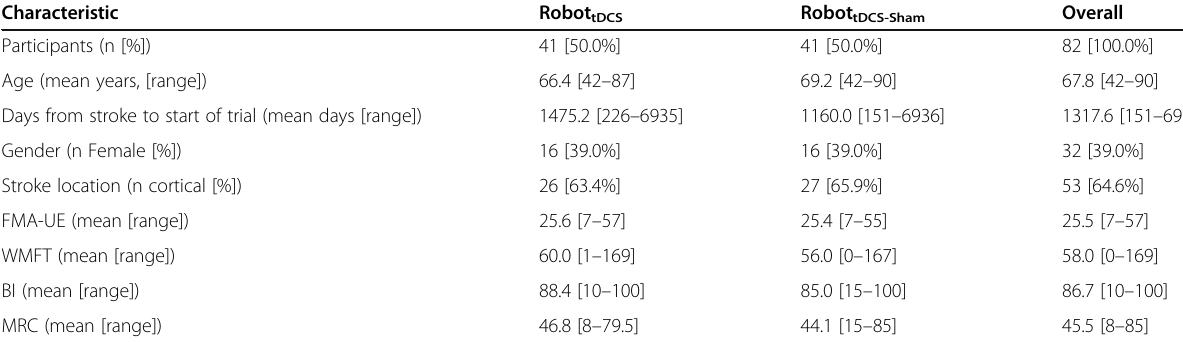
Table 4 Participant characteristics and admission results of clinical measures